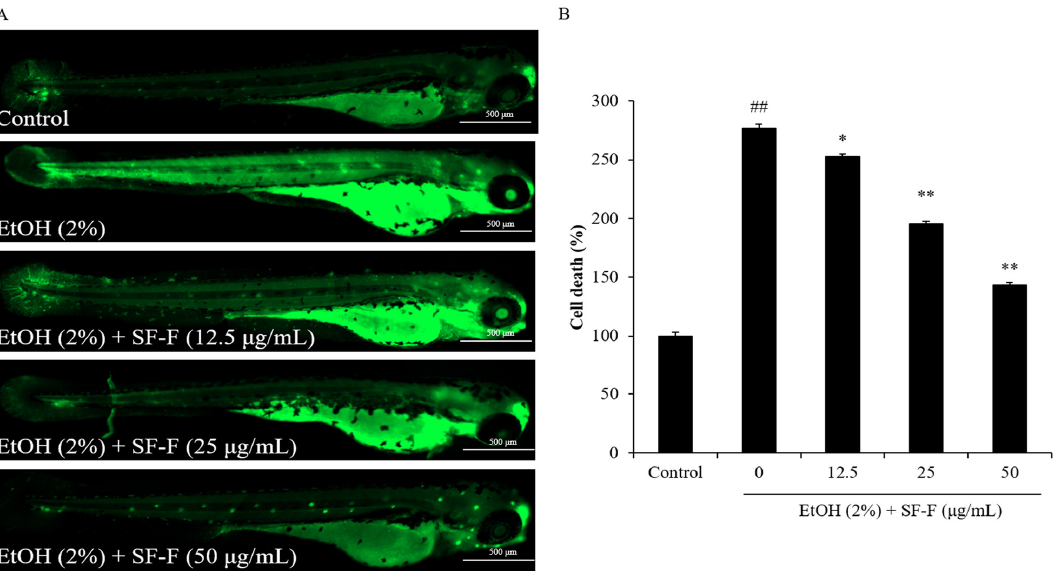
Figure 4. The protective e ff ect of SF-F during EtOH-induced ROS production in zebra fi sh. ( A ) Zebra fi sh under fl uorescence microscope; ( B ) the levels of ROS generation. ROS was detected by DCFH2-DA staining and ROS levels of EtOH-treated zebra fi sh were measured by ImageJ software. The experiments were conducted in triplicate, and the data are expressed as the mean ± SE ( n = 3). * p < 0.05, ** p < 0.01 as compared to the EtOH-treated group and ## p < 0.01 as compared to the control group.